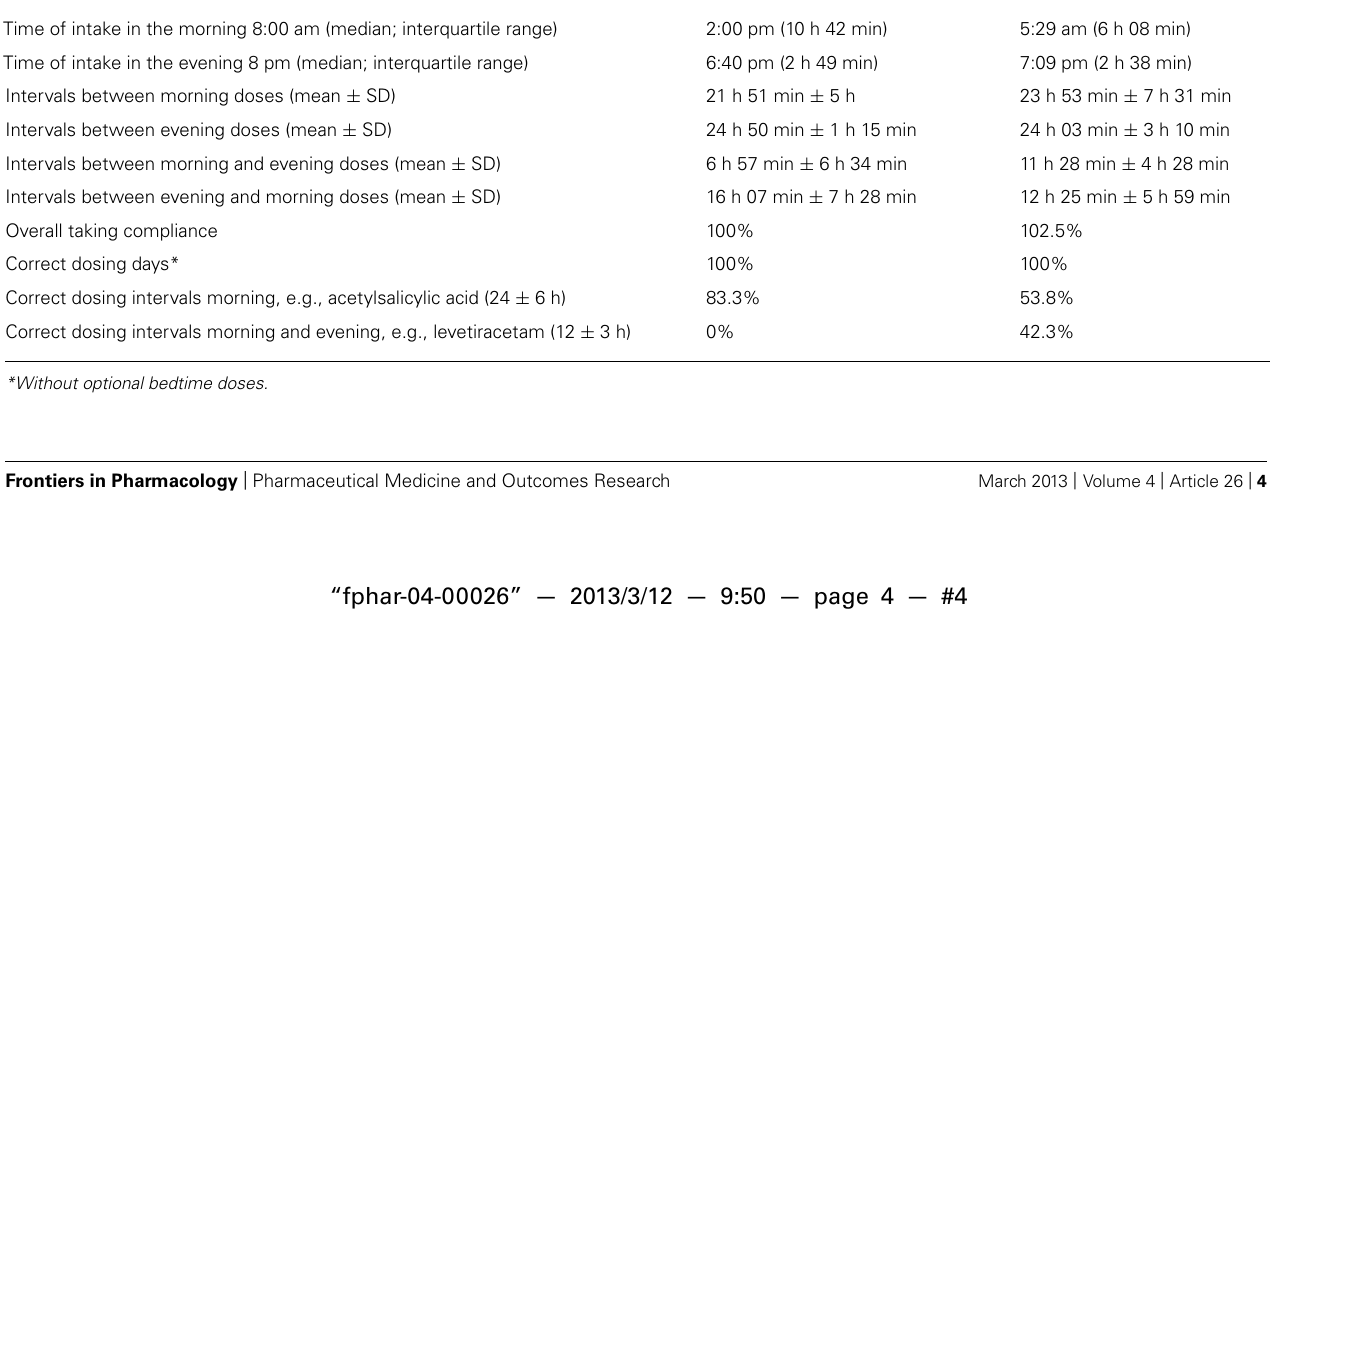
Table 1 | Intake times, intervals between doses, and adherence parameters for the two periods of adherence monitoring before (August 2010) and after (December 2010) the individualized intervention. Time of intake in the morning 8:00 am (median; interquartile range)